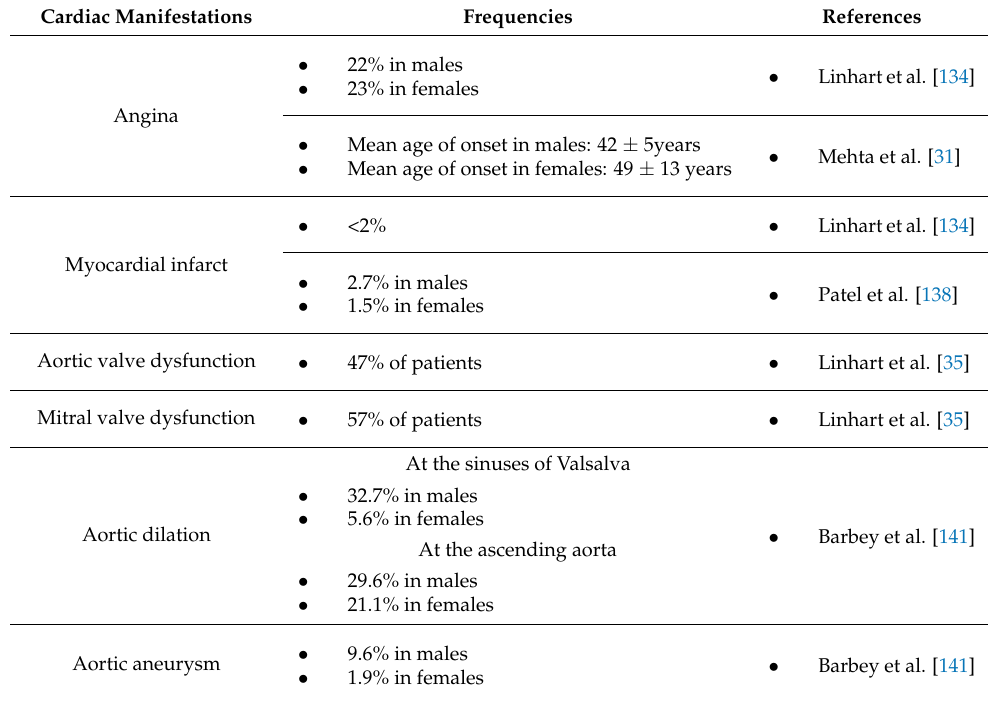
Table 4. Frequency of other cardiac manifestations in